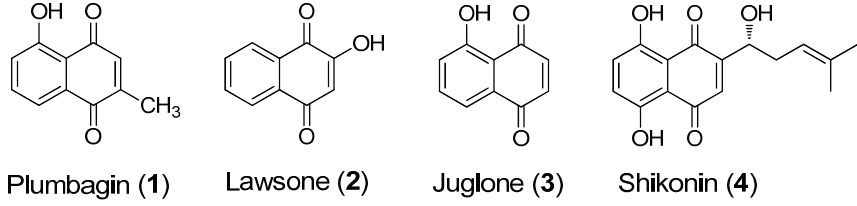
Figure 1. Chemical structures of plumbagin ( 1 ); lawsone ( 2 ); juglone ( 3 ) and shikonin ( 4